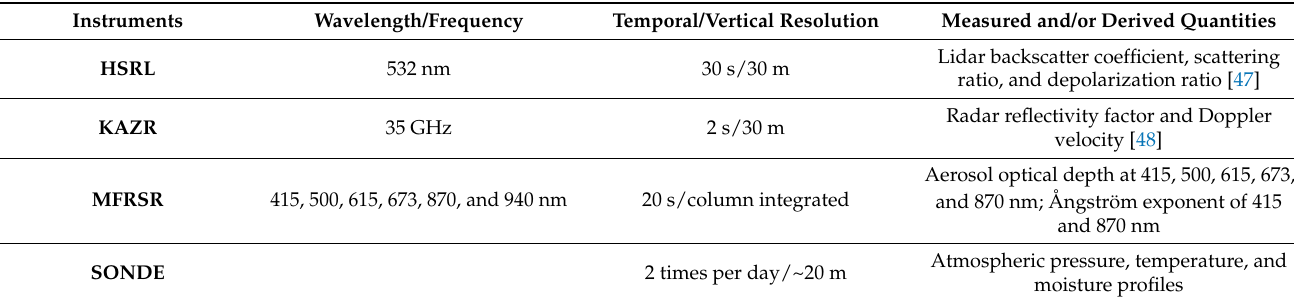
Table 1. Main instruments and measurements at the NSA Utqia˙gvik